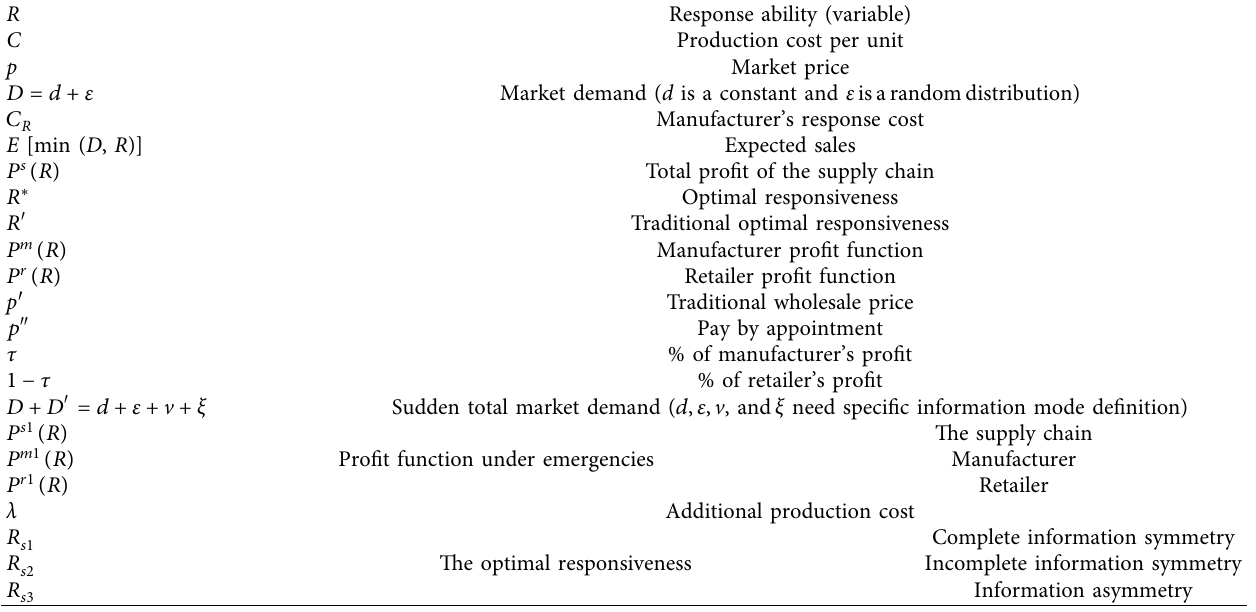
Table 1: Introducing the main